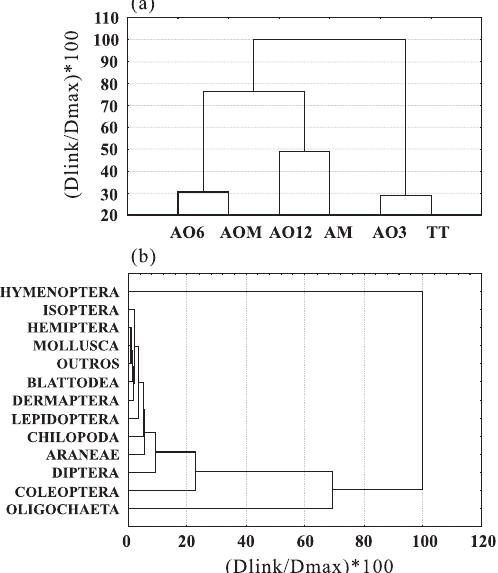
Figura 1. Dendrograma apresentando as distâncias de ligação entre os tratamentos (a), por meio da abundância dos grupos (organismos por m 2 ) da macrofauna edáfica na profundidade de 0–10 cm (b). Média de seis repetições e três épocas de coleta. TT: testemunha; AM: adubação mineral; AOM: adubação organomineral; AO3: adubação orgânica com 3 t ha -1 ; AO6: adubação orgânica com 6 t ha -1 ; AO12: Adubação orgânica com 12 t ha -1 . Outros: somatório de organismos com menor